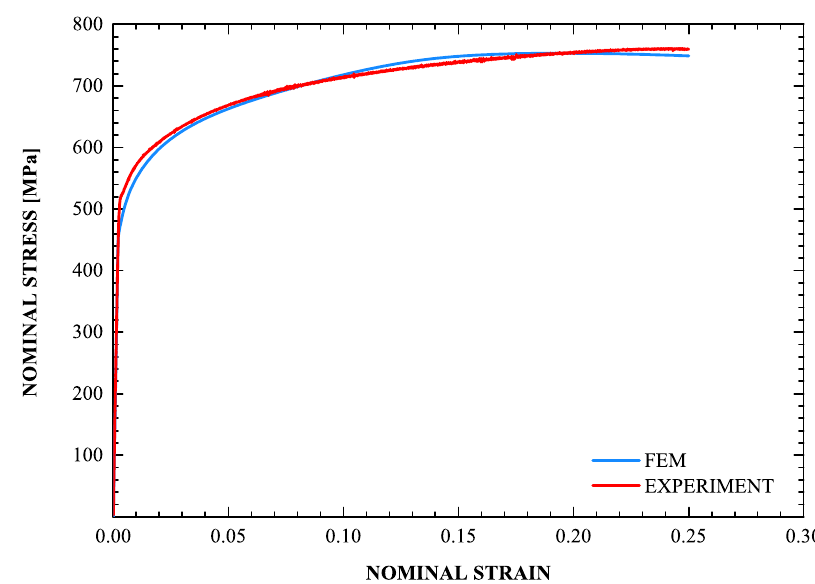
Figure 13. Calculated σ - ε curve (blue line) together with the experimental data (red